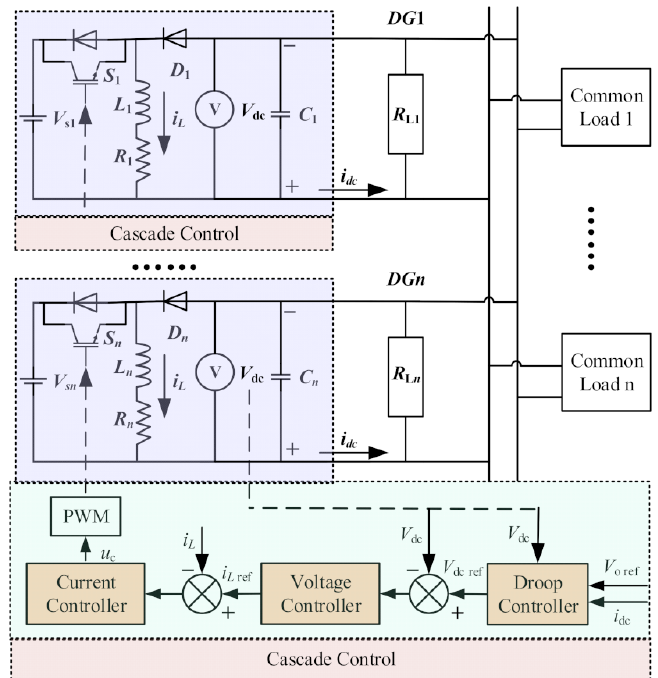
Figure 1. The control structure of the DC